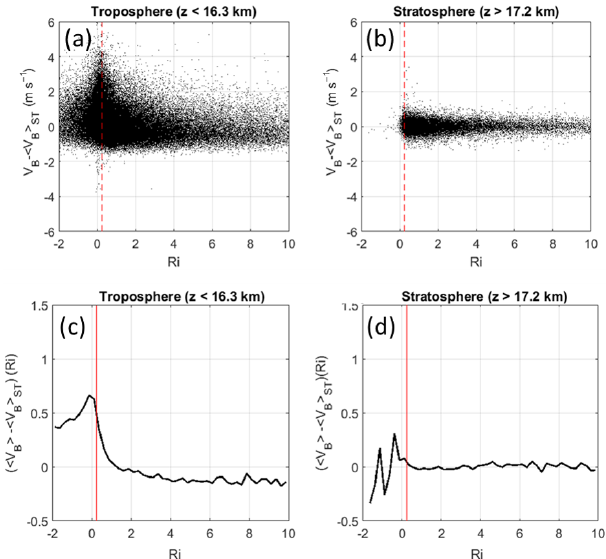
Figure 9. (a) Scatterplot of V Bc = V B −(cid:104) V B (cid:105) ST versus moist Ri for the troposphere. (b) Same as (a) for the stratosphere. (c) Mean values of V Bc in Ri bands of 0.25 in width for the troposphere. (d) Same as (c) for the stratosphere. The vertical red lines show Ri c = 0 .